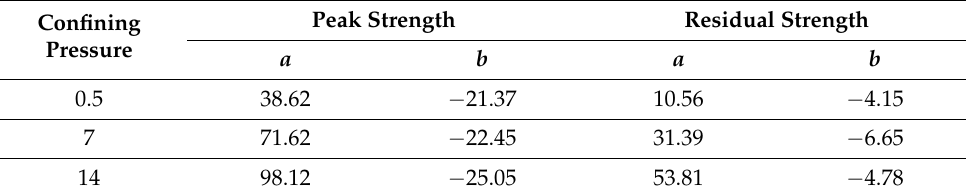
Table 1. Peak and residual strength water absorption fitting coefficients.